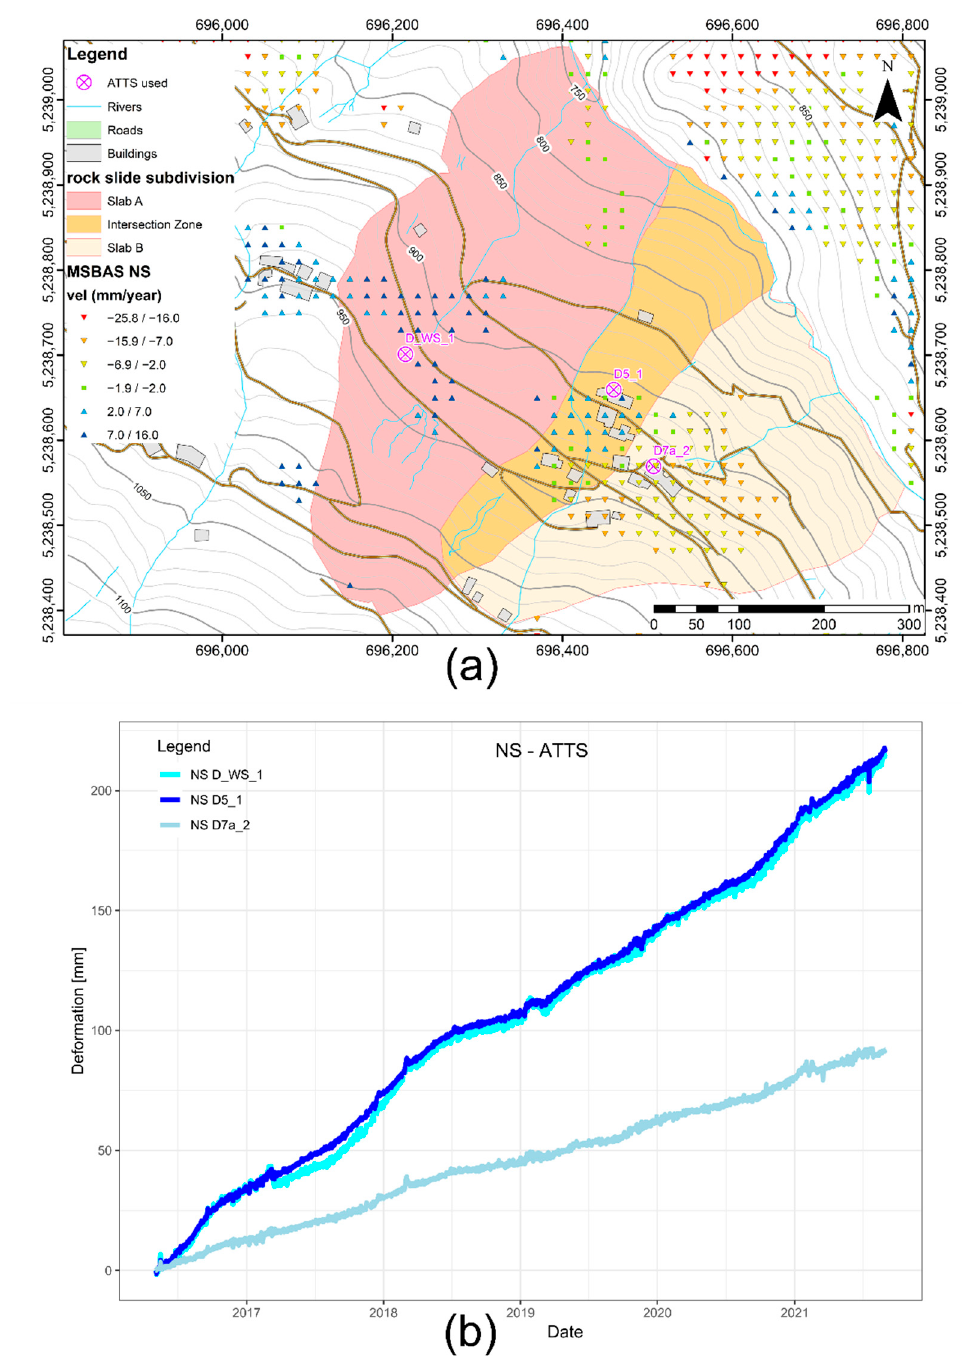
Figure 4. MSBAS velocities ( a ) and ATTS time series ( b ) for the North-South (NS) direction of motion at the Vögelsberg landslide.